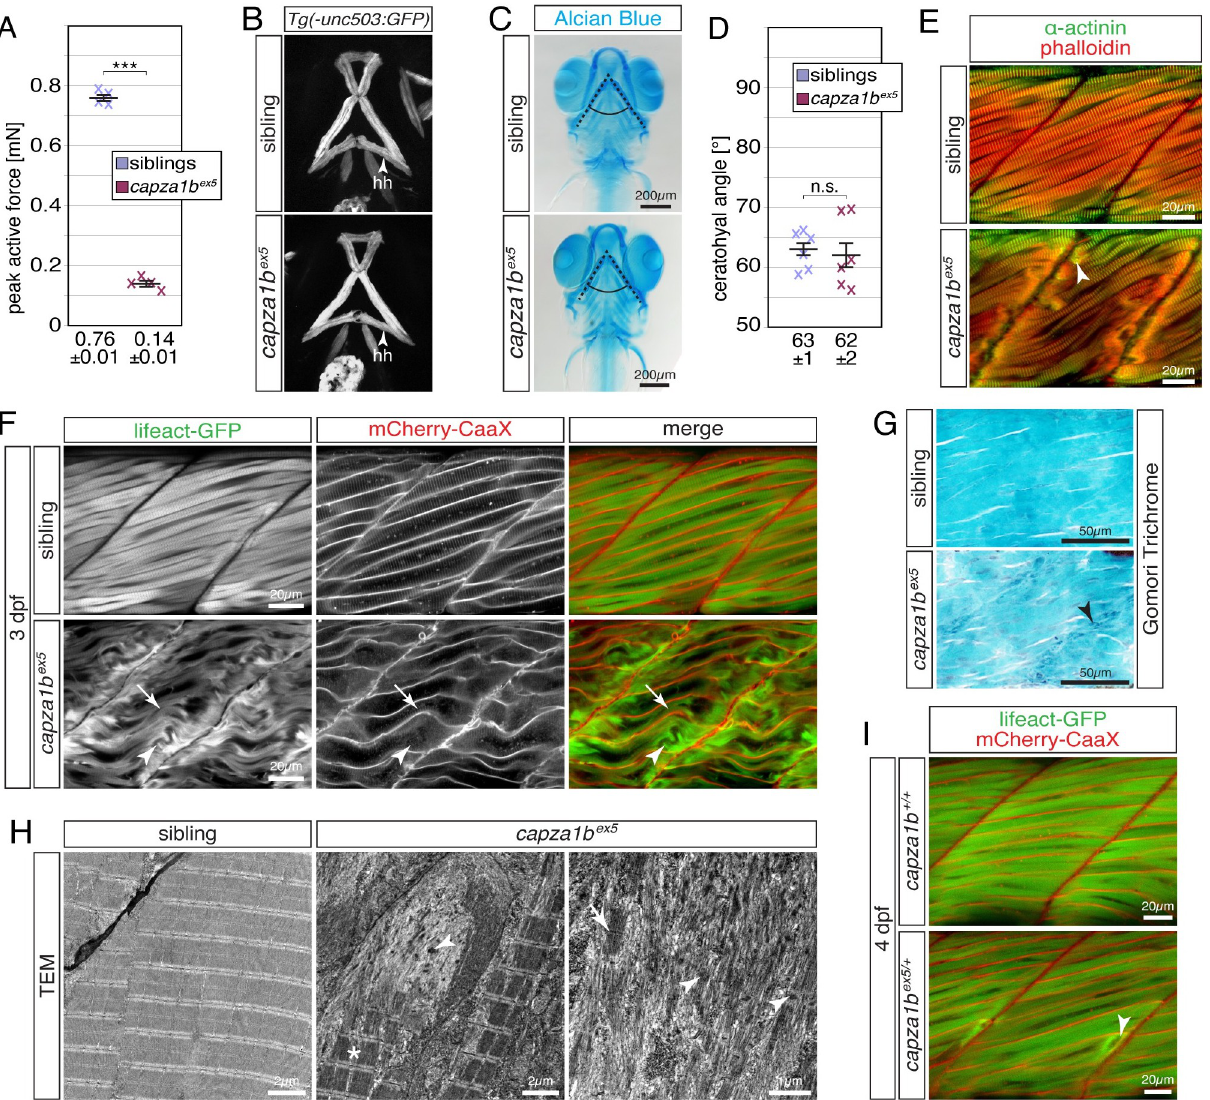
Fig 5. Thin filament deposits and myofibril disruptions lead to muscle weakness within the trunk but not head musculature of capza1b ex5 mutants. (A) Whereas 6-dpf-old siblings were able to generate a peak active force of 0.76 ± 0.01 mN, the force generated by capza1b ex5 homozygotes was significantly reduced to 0.14 ± 0.01 mN (n = 4). (B) GFP fluorescence driven by Tg(-503unc : GFP) showed that the two hyohyoideus (hh) muscles of capza1b ex5 homozygotes and siblings are comparable at 4 dpf (Z-stack projections of ventral views). (C) Focus stacks of Alcian Blue cartilage stains of capza1b ex5 homozygotes and siblings were comparable at 7 dpf. (D) The ceratohyal angle (dotted lines) of capza1b ex5 homozygotes was with 62 ± 2˚ not significantly different from the angle of 63 ± 1˚ formed in siblings (n = 6). (E) Phalloidin (red) and antibodies against α -Actinin (green) marked aggregates (arrowhead) close to the vertical myosepta within 3-dpf-old capza1b ex5 homozygotes but not siblings. (F) Lifeact-GFP (green) highlighted organised myofibril (arrow) in life siblings and capza1b ex5 homozygotes at 3dpf. In addition to the residual striation, capza1b ex5 homozygotes featured myofibril ruptures (arrowhead) as well as aggregates and thin filament deposits at the peripheral myofibre ends. Transgenic mCherry-CaaX (red) was used to mark the sarcolemma and t-tubules. (G) On 3 dpf sagittal sections, Gomori trichrome-staining exposed blue/purple structures (arrowhead) close to the vertical myosepta of capza1b ex5 homozygotes, but not siblings. (H) At 3 dpf, sarcomeres were organised within siblings as revealed by transmission electron micrographs. Organised sarcomeres were also present within capza1b ex5 homozygotes (star). However, sarcomere organisation was lost in capza1b ex5 close to myofibres’ ends and filament deposits, where isolated sarcomeric structures (arrow) and electron-dense aggregates (arrowhead), often with a lattice structure, were found instead. (I) Interestingly, myofibril ruptures were detected in 4-dpf-old capza1b ex5/+ heterozygotes but not WT siblings, demonstrating capza1b haploinsufficiency. Data are presented as mean ± SEM; n.s. not significant and ��� P < 0.001 calculated by Student’s t test. Scale bar sizes are indicated.